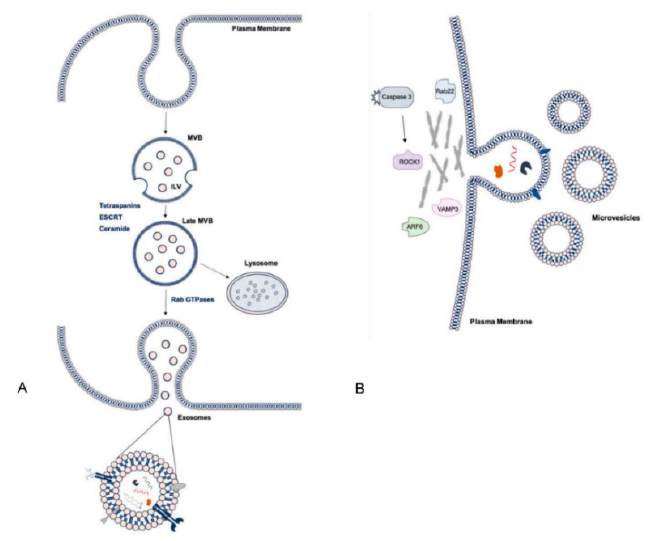
Figure Figure 3. Pathways of small extracellular vesicle (sEV) biogenesis and summary of cargo. ( A ) Intraluminal vesicles (ILVs) are formed by invagination of the early endosomal membrane and subsequently secreted as exosomes. Multivesicular body (MVB) formation may be dependent on tetraspanins and ESCRT machinery or ceramides and trafficking to the membrane involves Rab